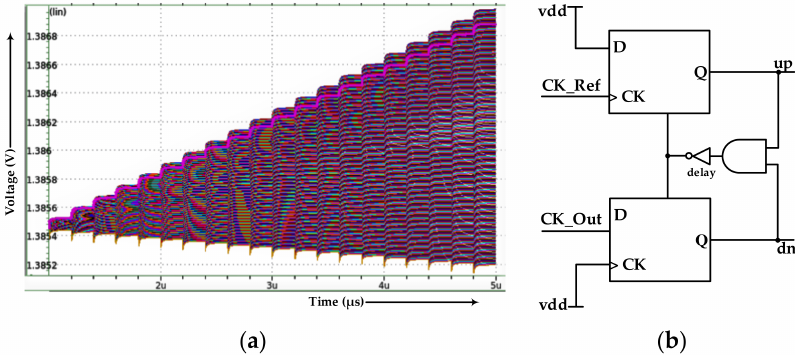
Figure 13. ( a ) PFD dead zone simulation; ( b ) PFD block diagram (delay inclusion).